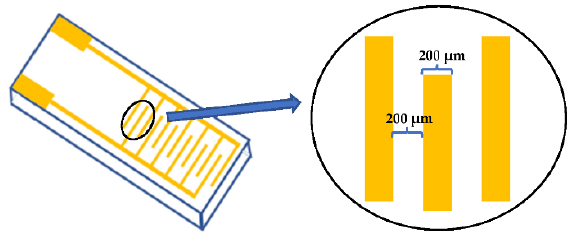
Figure 1. Schematic representation of the ceramic substrates with gold IDE (200 µ m/200 µ m) acquired from DropSens (Asturias, Spain) and used in this work.